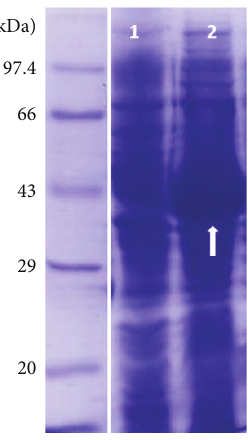
Figure 2: Coomassie blue stained SDS-PAGE analysis of recom- binant ST3Gal-I in E . coli strain BL21 (DE3): lane 1: uninduced rST3Gal-I culture; lane 2: induced rST3Gal-I culture. Protein molec- ular weight marker from Merck was used. Arrow showed induced recombinant protein.